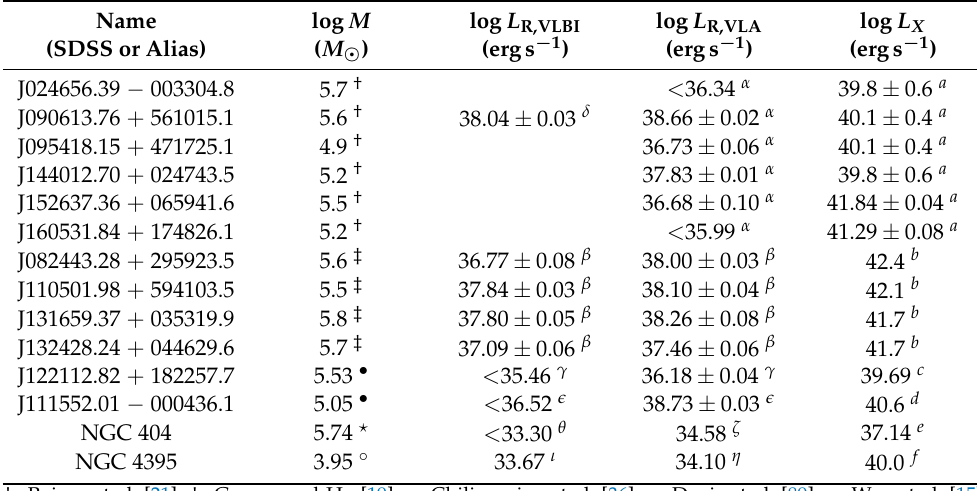
Table 1. IMBH candidates with both radio and X-ray